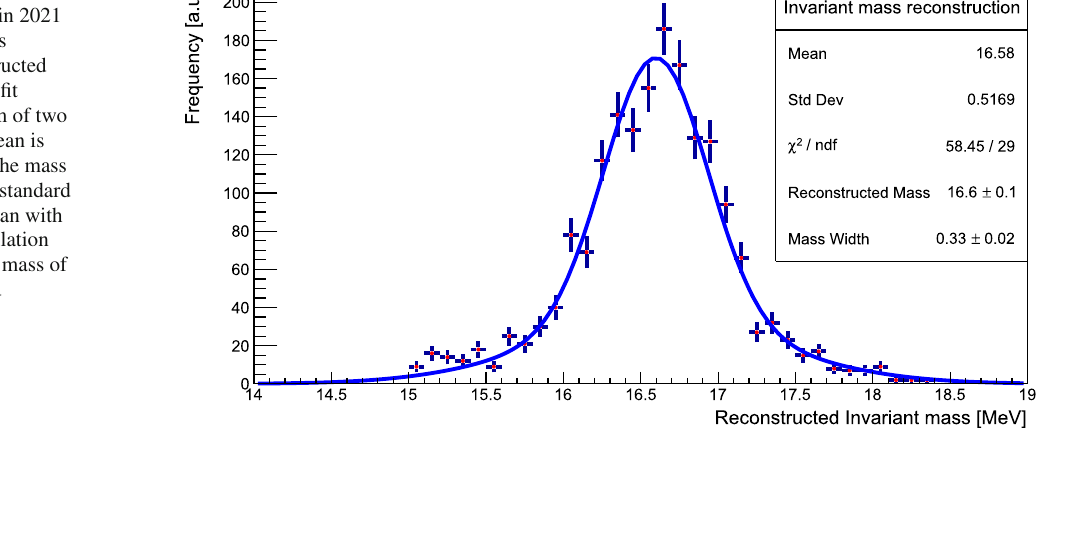
Fig. 11 Sketch of the setup proposed for the 2021 visible mode of NA64. Top view and side view are shown in the top and bottom pictures respectively Fig. 12 Reconstructed invariant mass of X 17 in 2021 setup. 90% of all events considered are reconstructed with 10% precision. A fit performed with the sum of two Gaussian with same mean is shown as a blue line. The mass width is defined as the standard deviation of the Gaussian with largest norm. The simulation was performed using a mass of